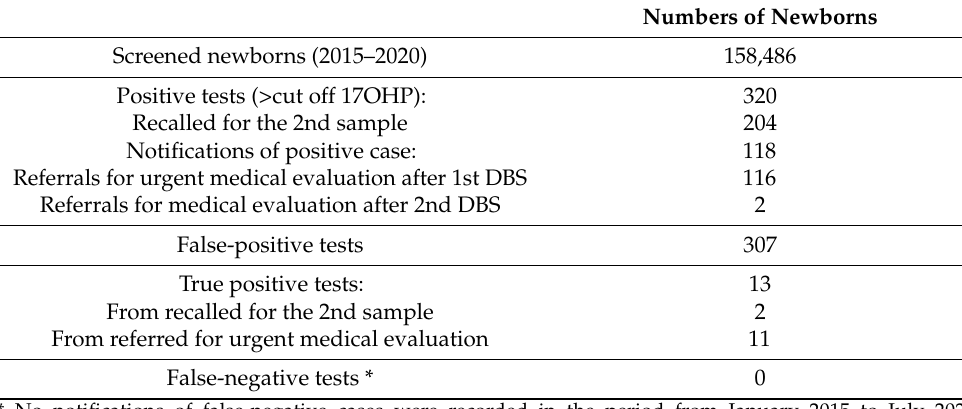
Table 2. Results of CAH screening from 2015 to